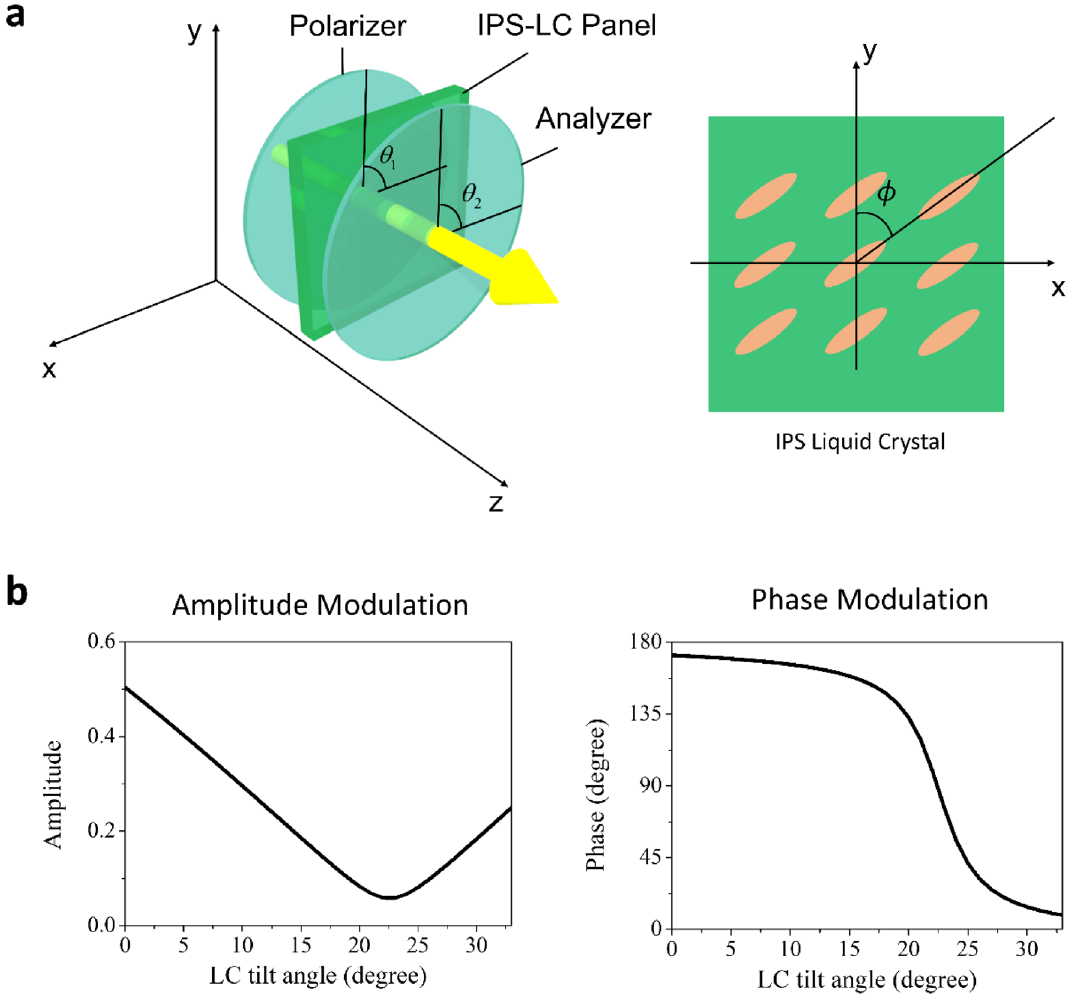
Figure 1. ( a ) Schematics of the single pixel of the conventional single-layer IPS-LC SLM (left panel) and its IPS-LC layer (right panel). ( b ) The amplitude (left panel) and phase modulation (right panel) characteristics of the single-layer